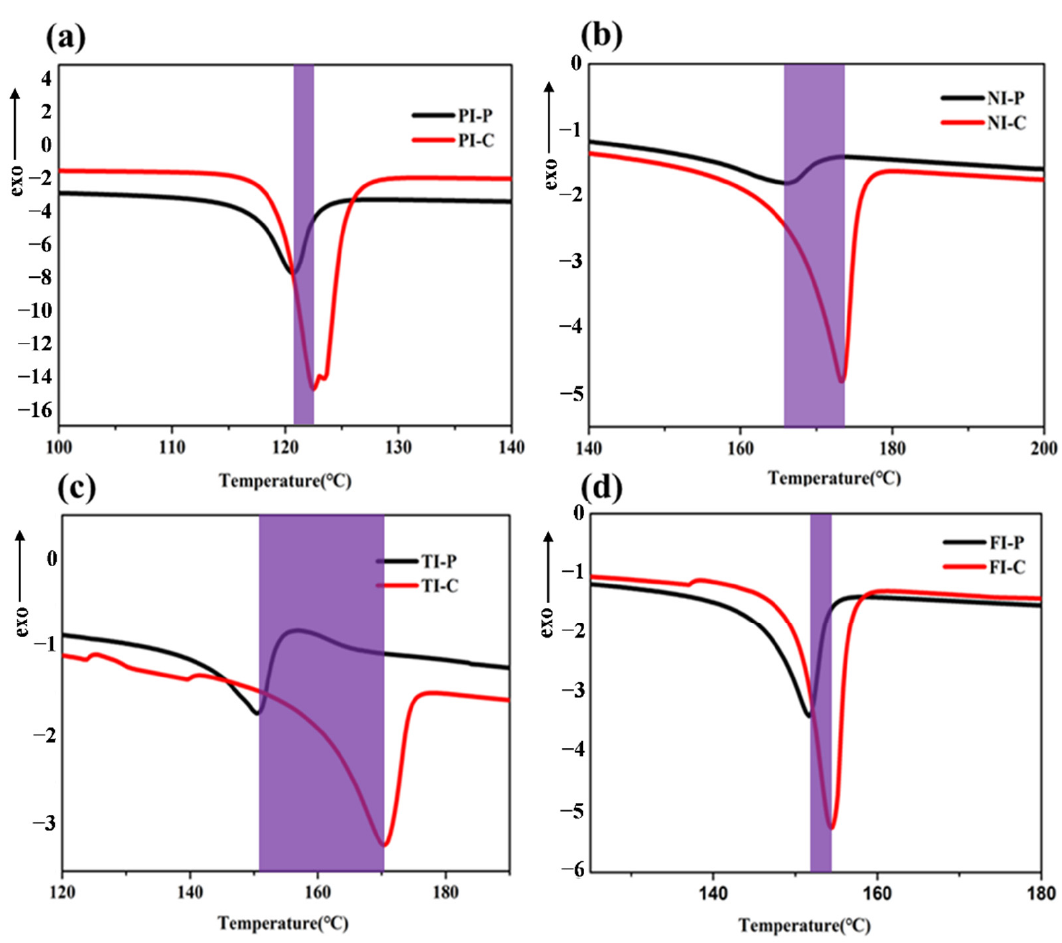
Figure 5. DSC curves of the crystals and precipitation samples for PI ( a ), NI ( b ), TI ( c ) and FI ( d ).